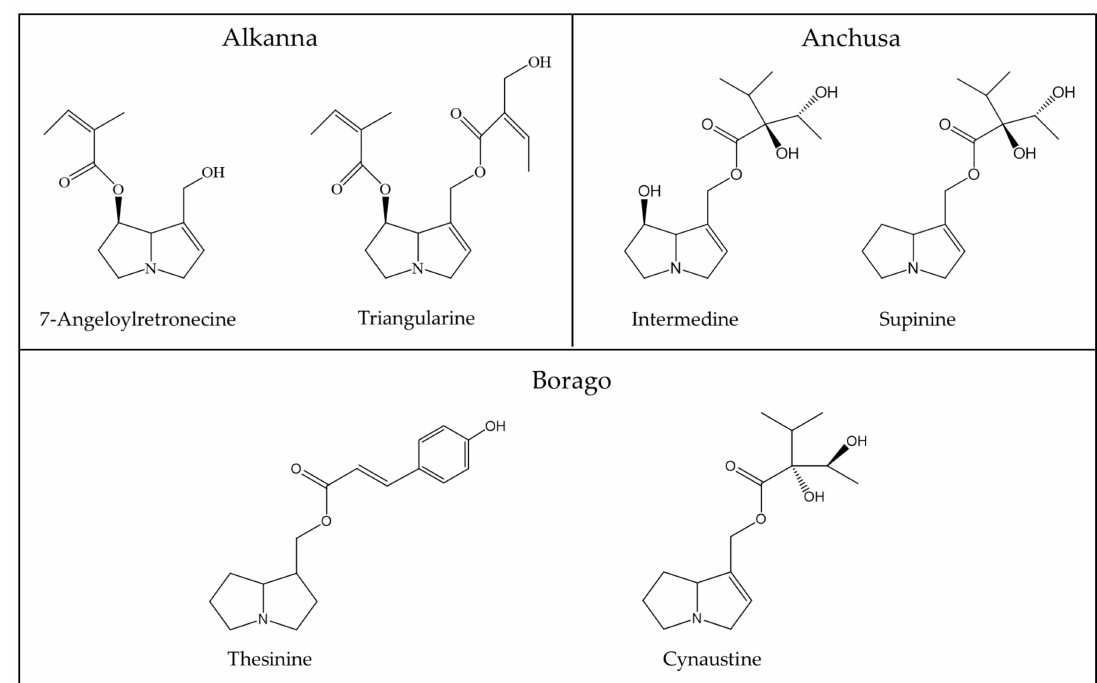
Figure 2. Selected pyrrolizidine alkaloids reported for the genera of Alkanna , Anchusa , and Borago . With the exemption of Thesinine, all other PAs are unsaturated and have a double bond between C1 and C2. The figure of the chemical structures was obtained from the open access report of Kopp et al. [56].